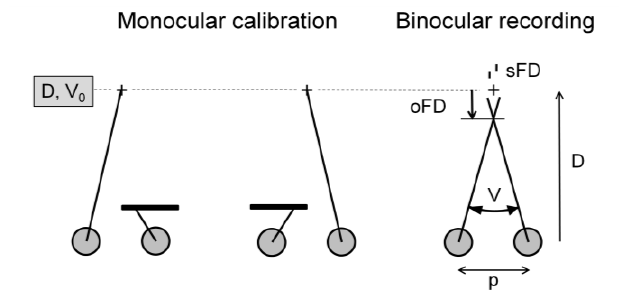
Figure 1: Eye position during monocular calibration of each single eye when the fellow eye is occluded and during the binocular recording when viewing the stimulus in Figure 2. The geometrically expected vergence angle V 0 depends on the viewing distance D and the interpupil distance p. Subjective fixation disparity (sFD) is given by the nonius offset and objective fixation disparity (oFD) by the vergence error V - V 0 . (Figure adopted from Schroth, Joos, & Jaschinski,